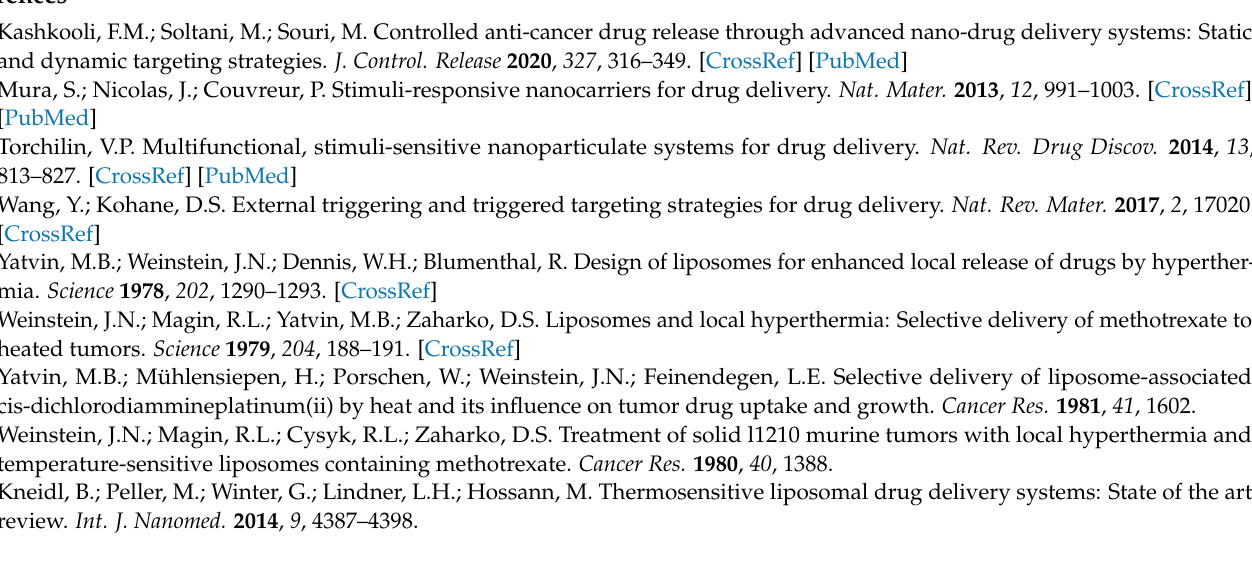
Figure 17. Interactions between TSL, drug, hyperthermia device, and tumor physiology/biology. The properties listed inside the arrows result from interactions between specific components (e.g., TSL and drug). These interactions must be carefully considered when designing TSL-drug-device combinations for optimal delivery.